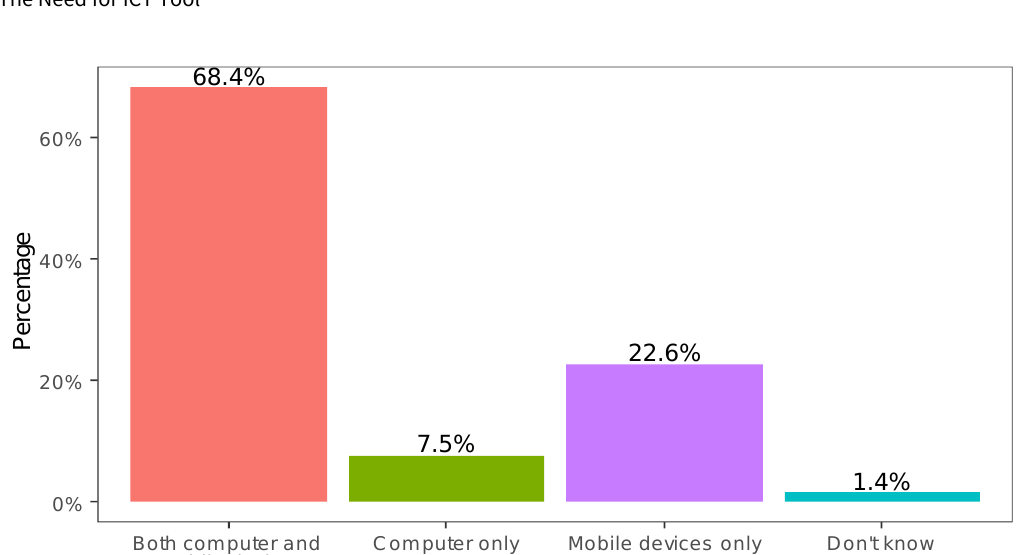
Figure 7. The Need for ICT Tool